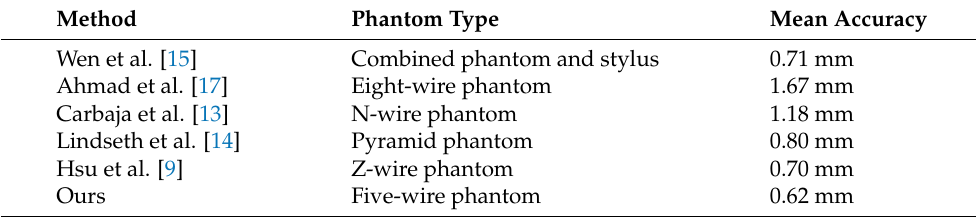
Table 6. Comparison with other SOTA US probe calibration